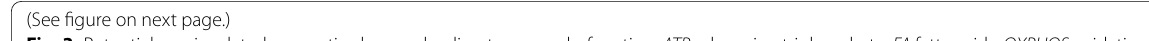
cell(See figure on next Fig. 3 Potential sepsis-related energetic changes leading to organ dysfunction. ATP adenosine triphosphate, FA fatty acids, OXPHOS oxidative phosphorylation, PPP pentose phosphate pathway, TEC tubular epithelial